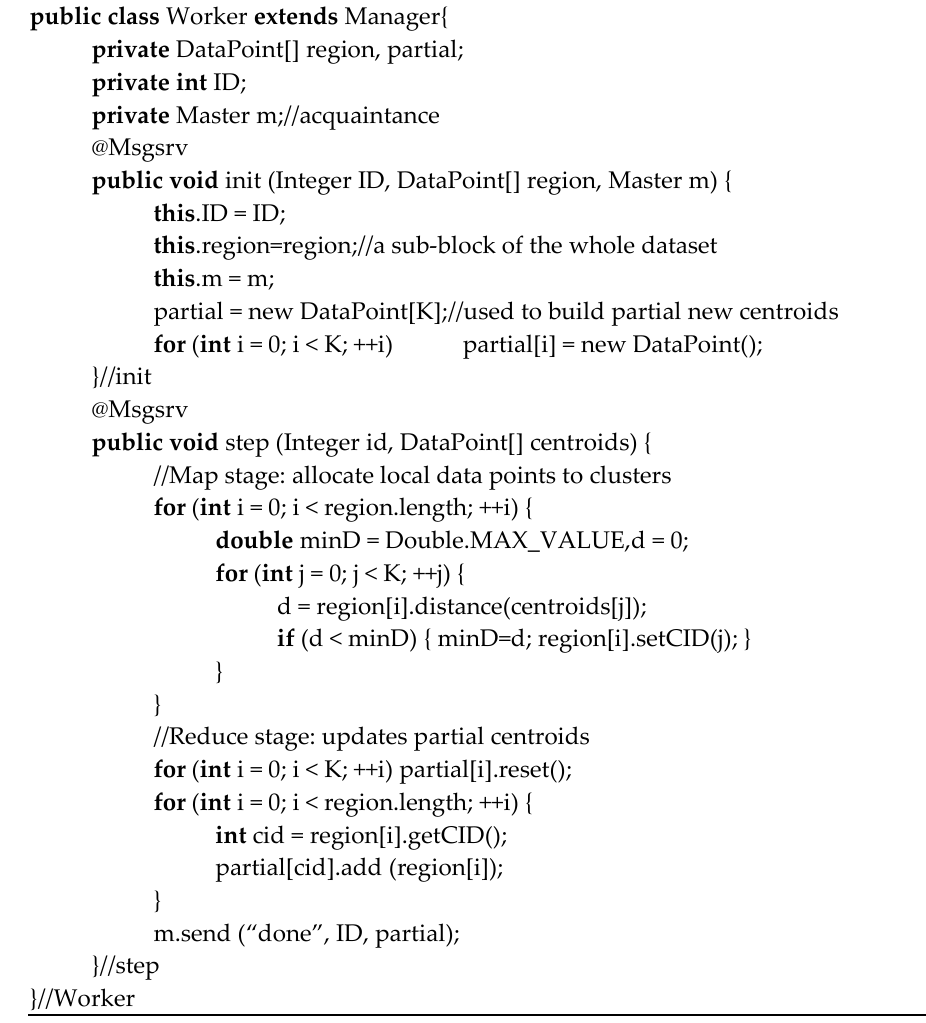
Figure 8. The Worker actor class. Table 1. Values of some configuration